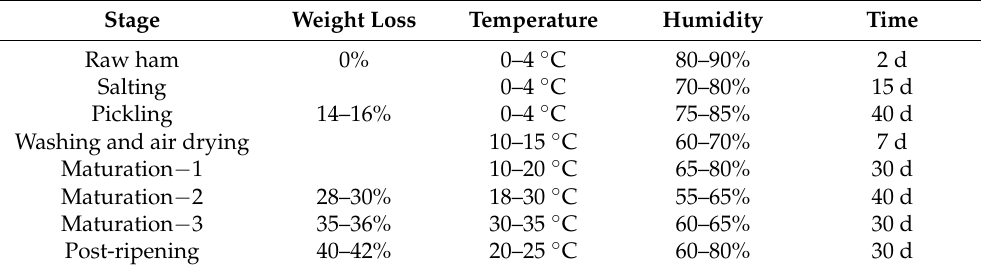
Table 2. The processing parameters of Jinhua ham with modern technology